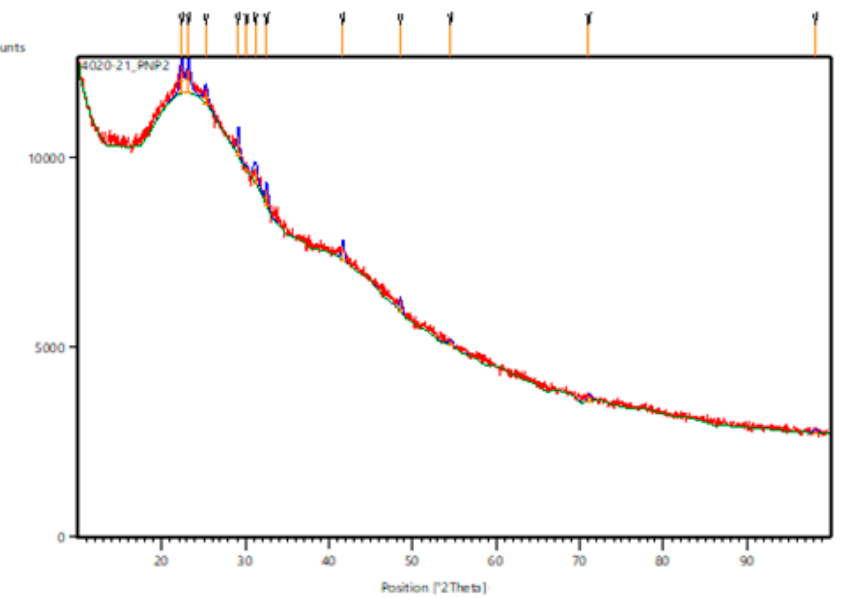
Figure 3. SEM image of the synthesized bismuth nanoparticles with image focus zoom 500 nm ( a ), 20 µ M ( b ), and 5 µ M ( c ).